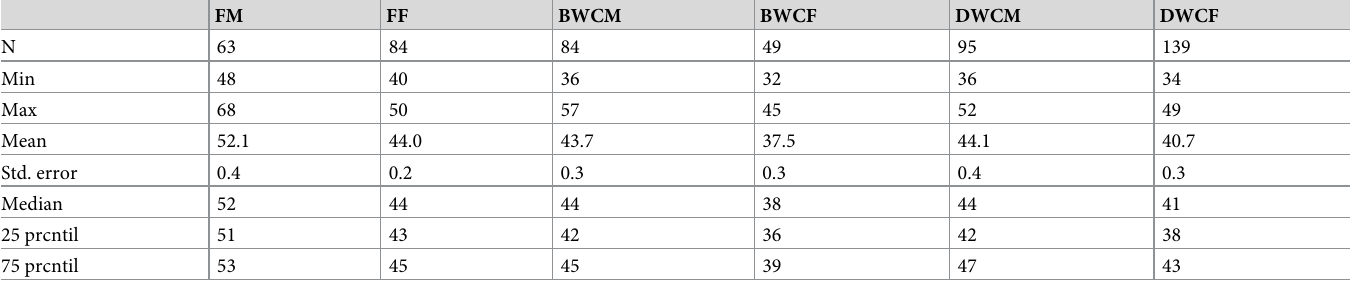
Table 1. Mink body length (cm) excluding the tails of farm males (FM), farmed females (FF), Bornholm wild caught males (BWCM) and females (BWCF), main- land Denmark wild caught males (DWCM) and females (DWCF) from samples collected from 2014–2018. Sample size (N), mean, minimum (Min), maximum (Max) values, standard errors (std. error), median and 25 and 75 percentiles (prcntil).